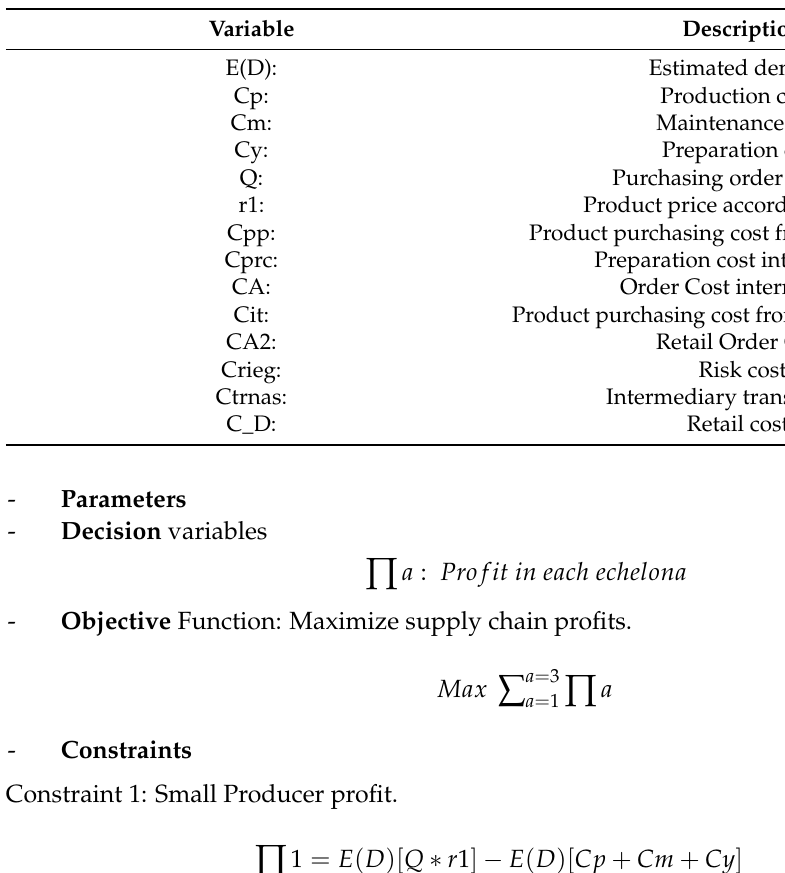
Table 3. Parameters Decentralized scenario modeling without a